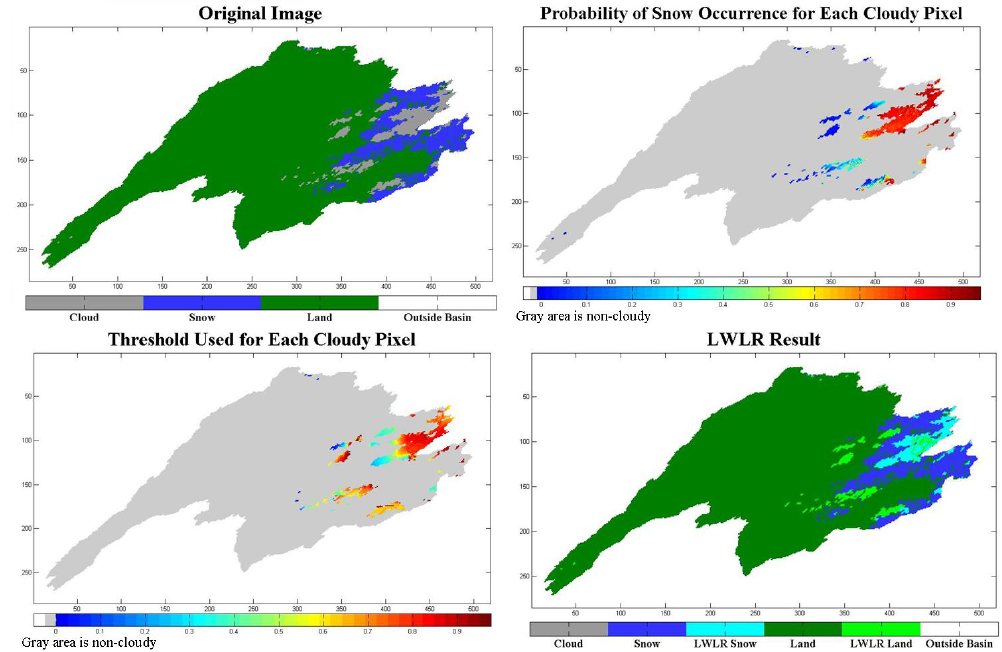
Fig. 4. Example of the transition from original to corrected MOD10A1 image (26 November 2004), along with maps of the estimated PSO and the values of the thresholds